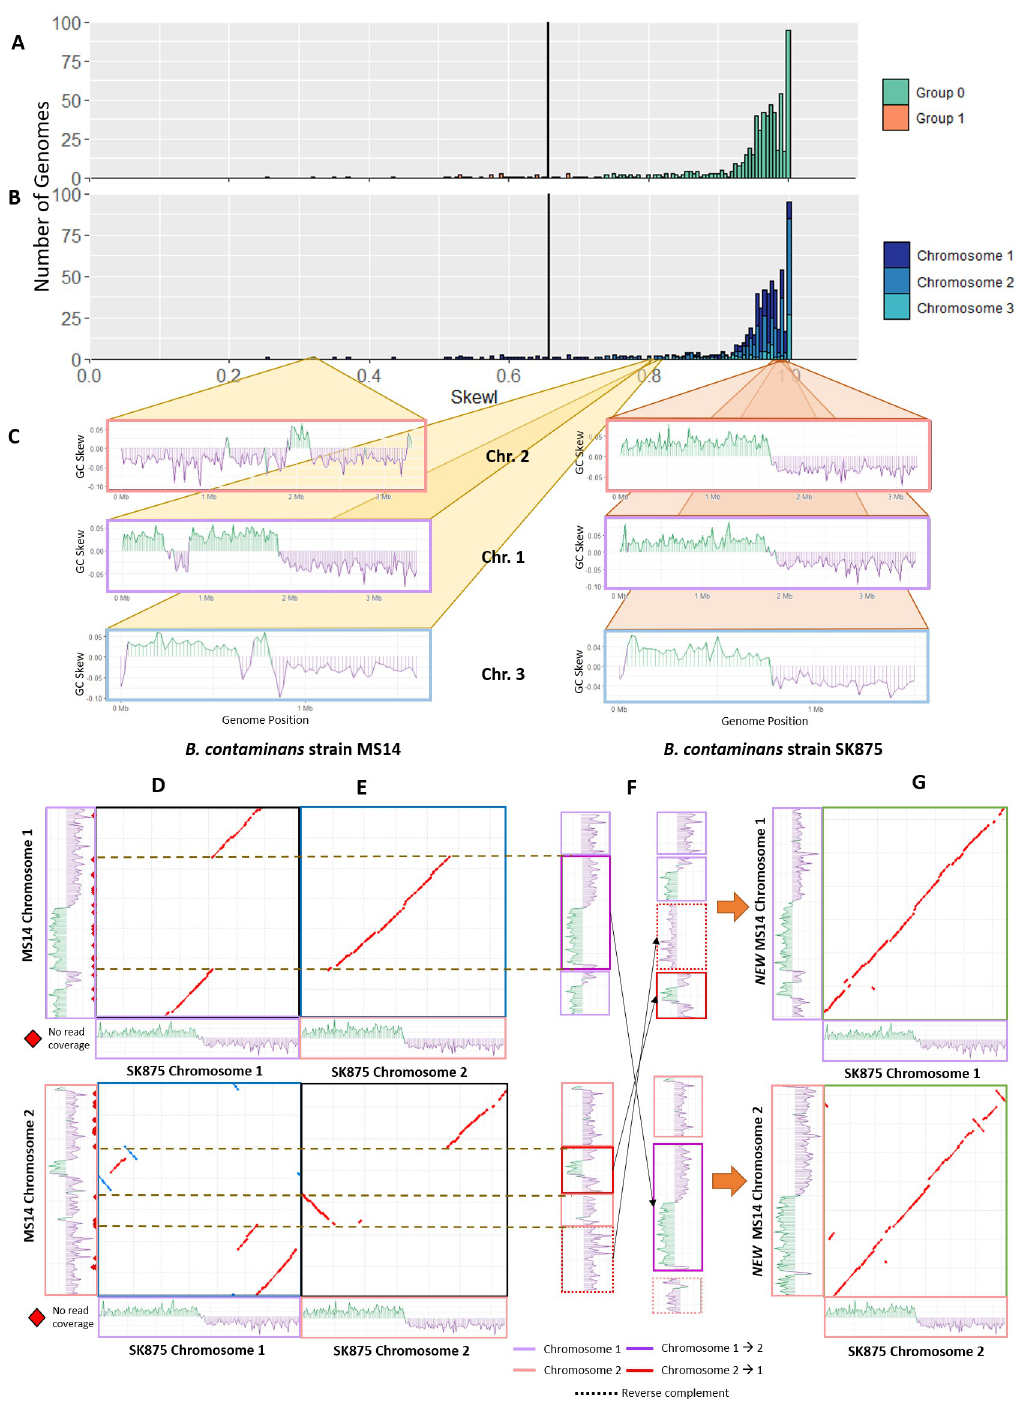
Fig 4. Burkholderia skew. A) SkewI for all 934 Burkholderia genomes. The threshold (vertical black line) is 0.715. B) SkewI colored by chromosome. C) GC-skew plots for all three chromosomes for Burkholderia contaminans strains MS14 (left) and SK875 (right). D) Alignments between MS14 and SK875 chromosomes 1 and 2. MS14 is shown on the y axis of each plot. E) Cross-chromosome alignments between MS14 and SK875 chromosome 1 and 2 reveal that a 1.7Mbp region of MS14 chromosome 1 actually belongs to chromosome 2. Similar matches in MS14 chromosome 2 suggest two regions that belong in chromosome 1. F) We rearranged and inverted the sequences of MS14 chromosomes 1 and 2 based on the alignments and GC-Skew plots. G) The final MS14 chromosomes alignment with those of B. contaminans SK875.